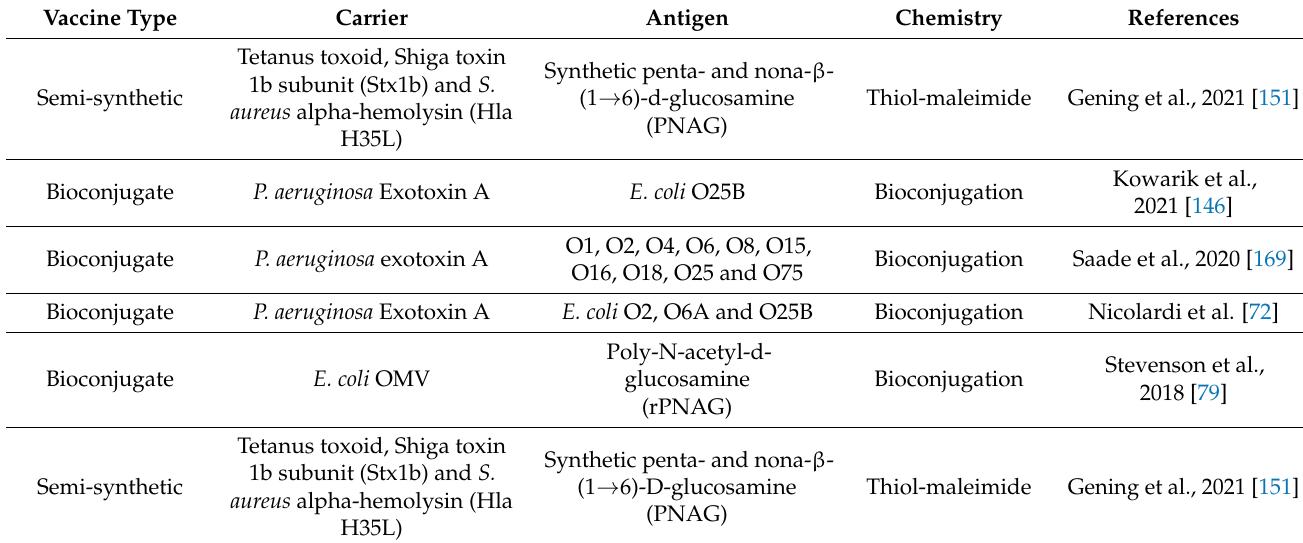
Table 13. Carbohydrate conjugate vaccines targeting Escherichia coli